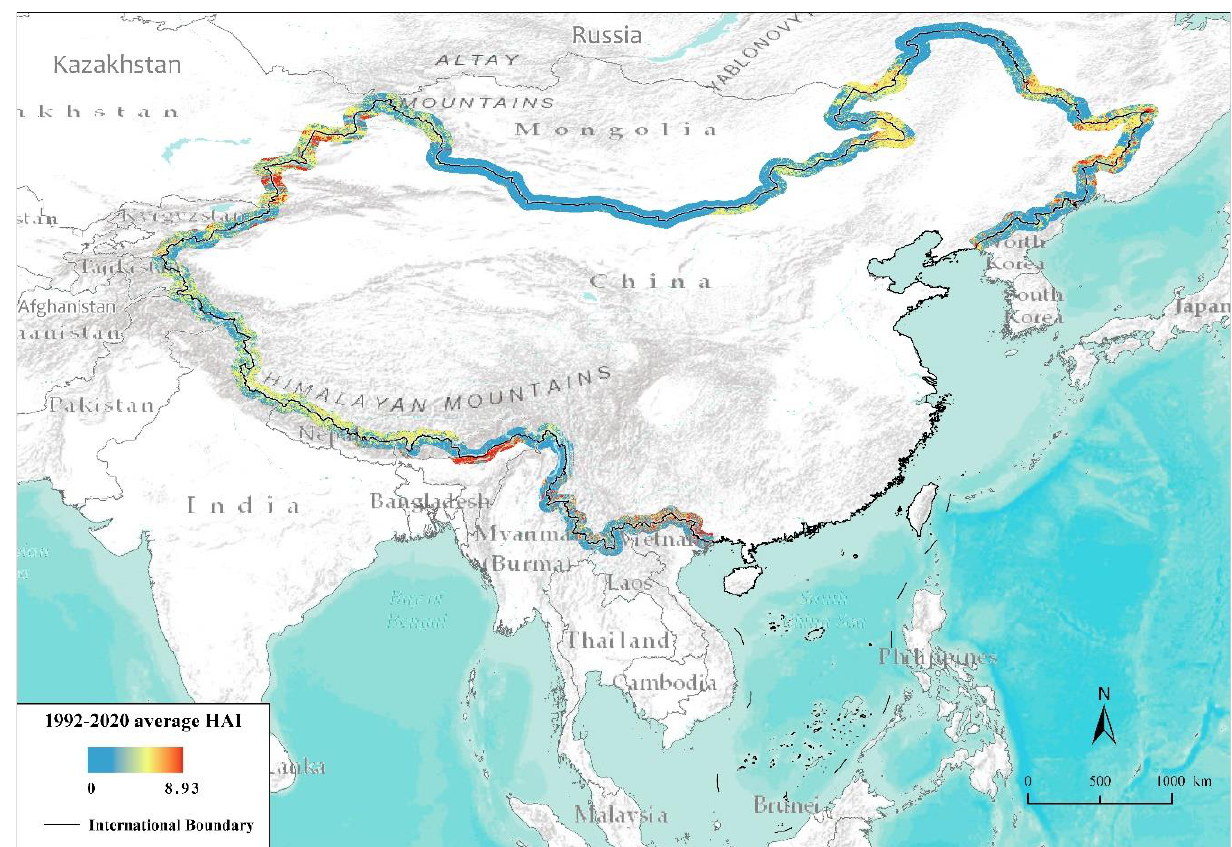
Figure 4. The average HAI, 1992 – 2020.